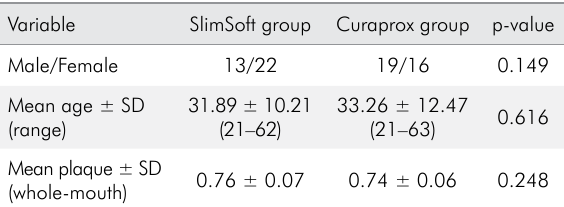
Table. Demographical and baseline characteristics of the study subjects.